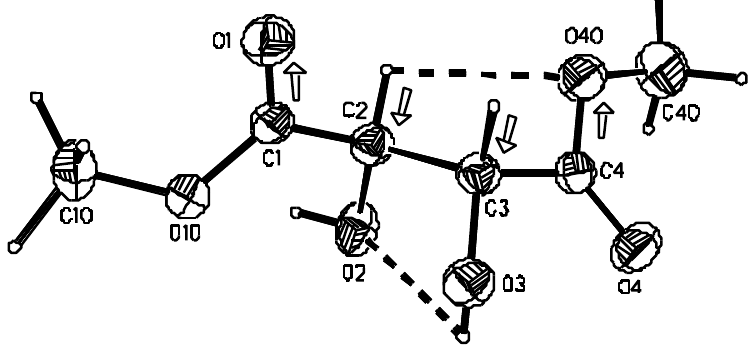
Figure 2. Perspective view of the molecule of (R,R)-tartaric acid dimethyl diester and the atom numbering scheme. Thermal ellipsoids were drawn at 40% probability level. Molecular conformation is stabilized by intramolecular hydrogen bonds (dashed lines) and attractive dipole-dipole interactions (dipoles marked with